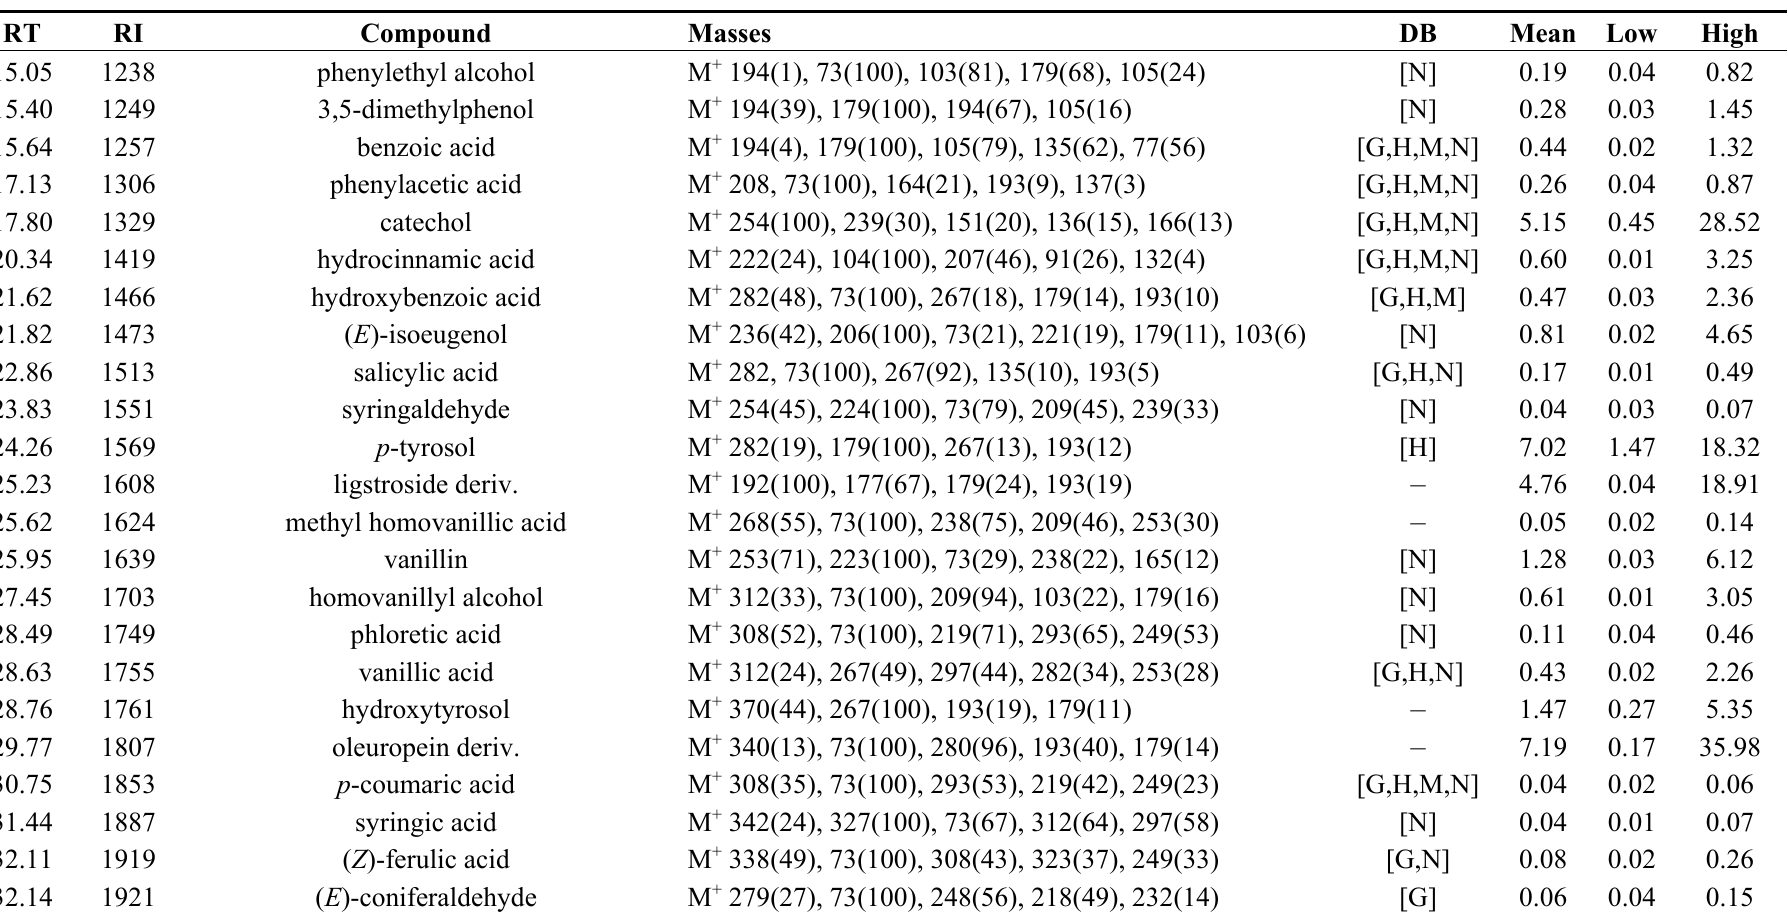
Table 2. Lowest, highest and mean levels of phenolic and cyclic structures detected in commercial olive oils (mg/kg FW). Retention time (RT) and retention index (RI) are based on an apolar HP-5MS column. The relative intensity (in %) of mass ions is shown in parenthesis. MS spectra included in publicly available databases (DB): [G] Golm Metabolome Database; [H] Human Metabolome Database; [M] MassBank; [N] NIST Chemistry